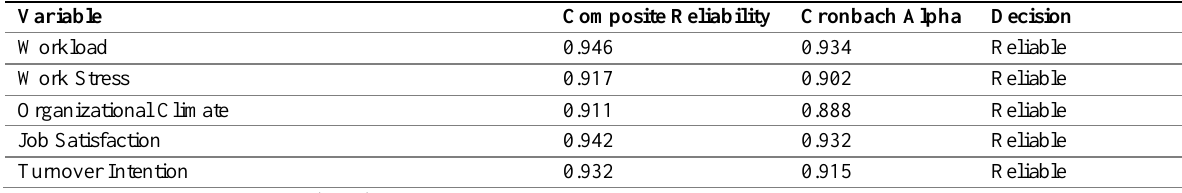
Table 4: Results of Composite Reliability and Cronbach Alpha